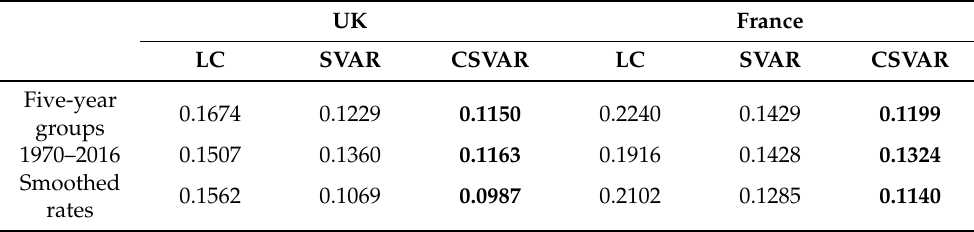
Table 2. Summary of robustness check. For each column, the smallest number is in